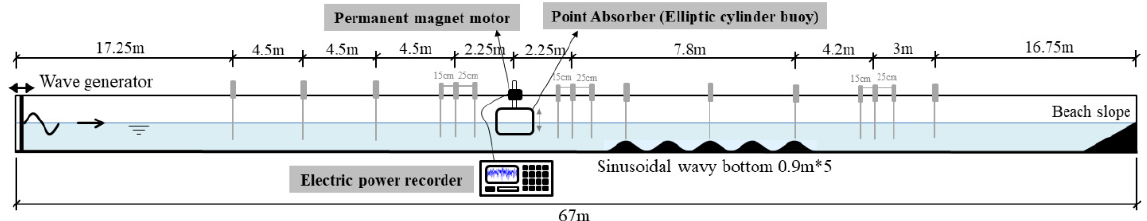
Figure 7. Experimental devices layout diagram for partial standing wave cases (Adapted from [35] with permission from Springer Nature).